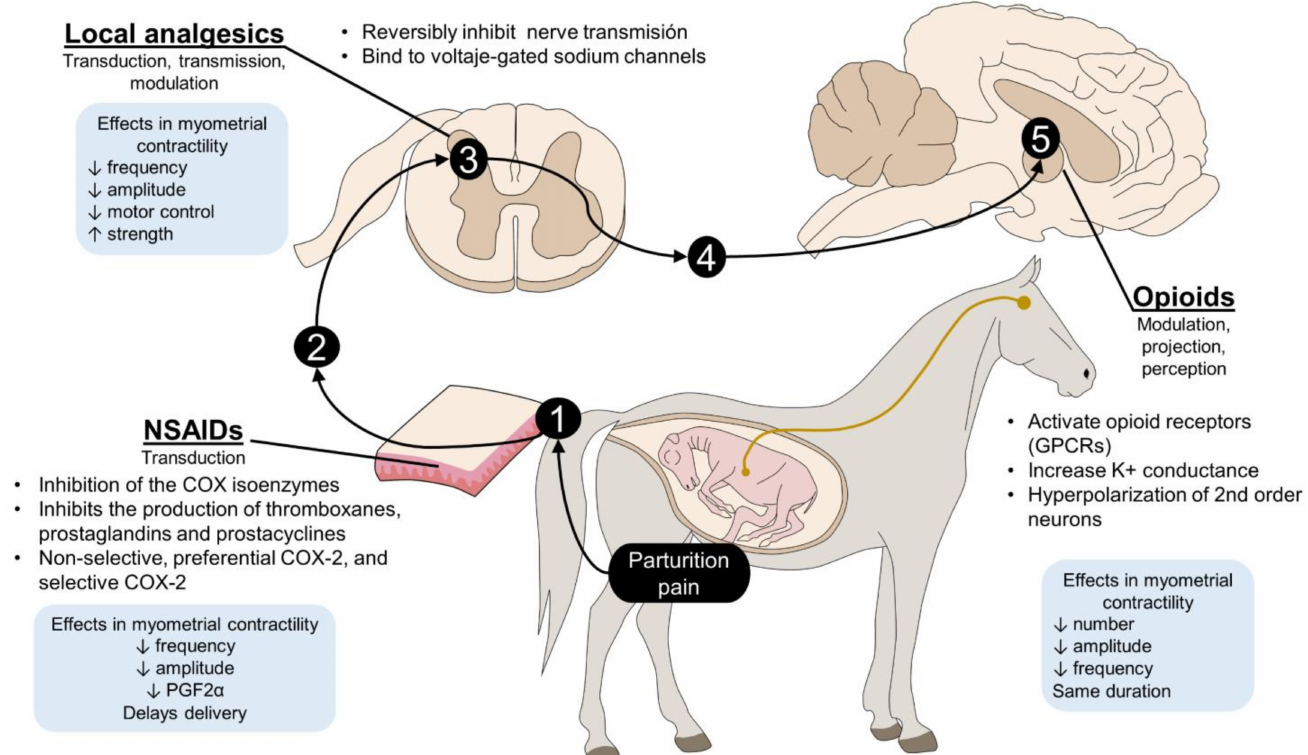
Figure 2. Action site of analgesics commonly used during parturition. Depending on their action mechanism, these drugs intervene at different levels of the nociceptive pathway. The NSAIDs block harmful impulse transduction by inhibiting COX and PG production, while LA can intervene in the first three stages of the nociceptive pathway by blocking voltage-gated sodium channels in the spinal cord. Secondly, opioids are centrally acting analgesics that hyperpolarize neurons to prevent the projection and perception of pain. In general, all three types of drugs can potentially decrease the frequency and amplitude of contractions of the uterus, but this effect depends on the drug and dose administered. 1: transduction; 2: transmission; 3: modulation; 4: projection; 5;